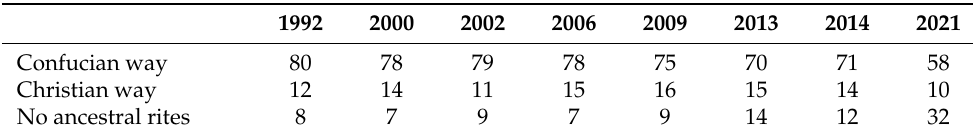
Table 6. Ways to practice ancestral rites during holidays (%), Gallup Korea. 1992